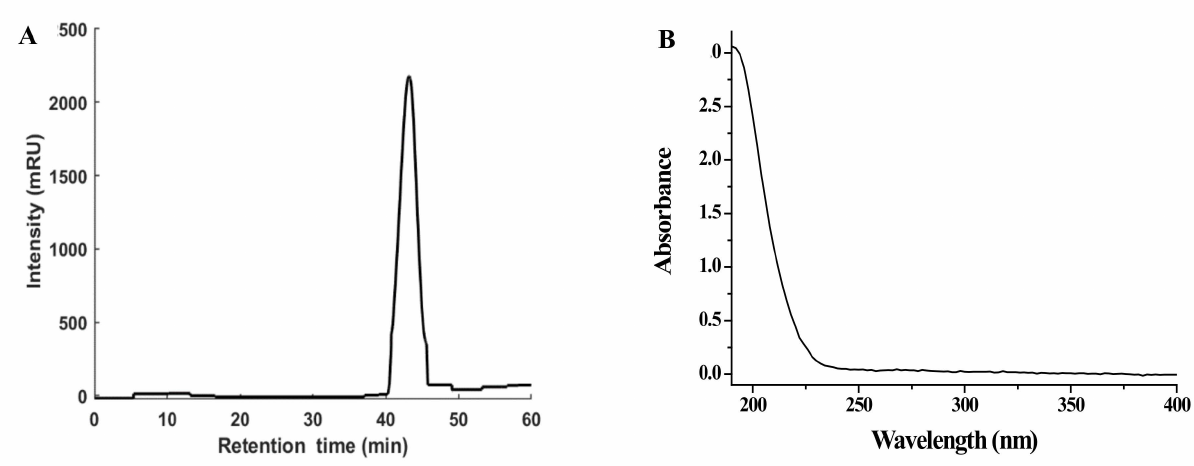
Figure 1. High performance gel permeation chromatography (HPGPC) of NPPc ( A ) and UV–vis spectrum of NPPc ( B